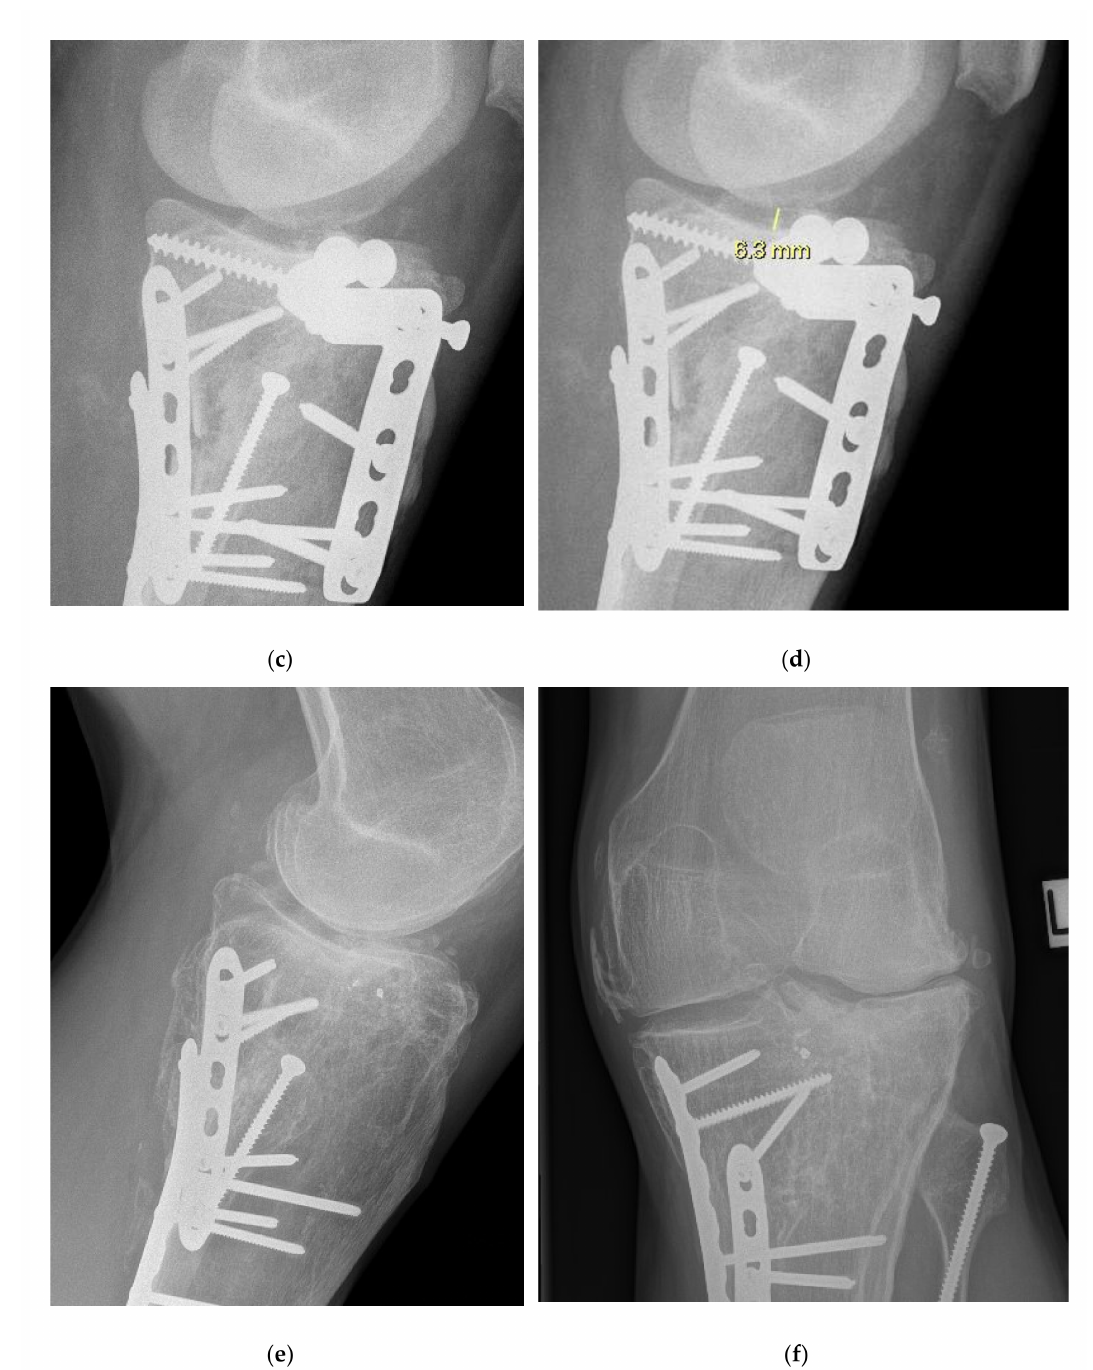
Figure 2. Pre- ( a ) and postoperative Day 2 ( b ) AP radiographs of a fracture that was not reduced (Schatzker VI) in a patient with Marfan syndrome. Note that the articular step is better visible on the lateral views ( c , d ). ( e , f ) Lateral and AP radiographs of the same fracture 5 years after injury following removal of the anterolateral plate and screws (removal of metalwork 21 months post primary surgery). Note the residual articular step and secondary degenerative changes. Despite fracture malreduction, the 5-year Lysholm score, KOOS pain score, and KOOS quality of life score were 80, 94.4, and 68.6,